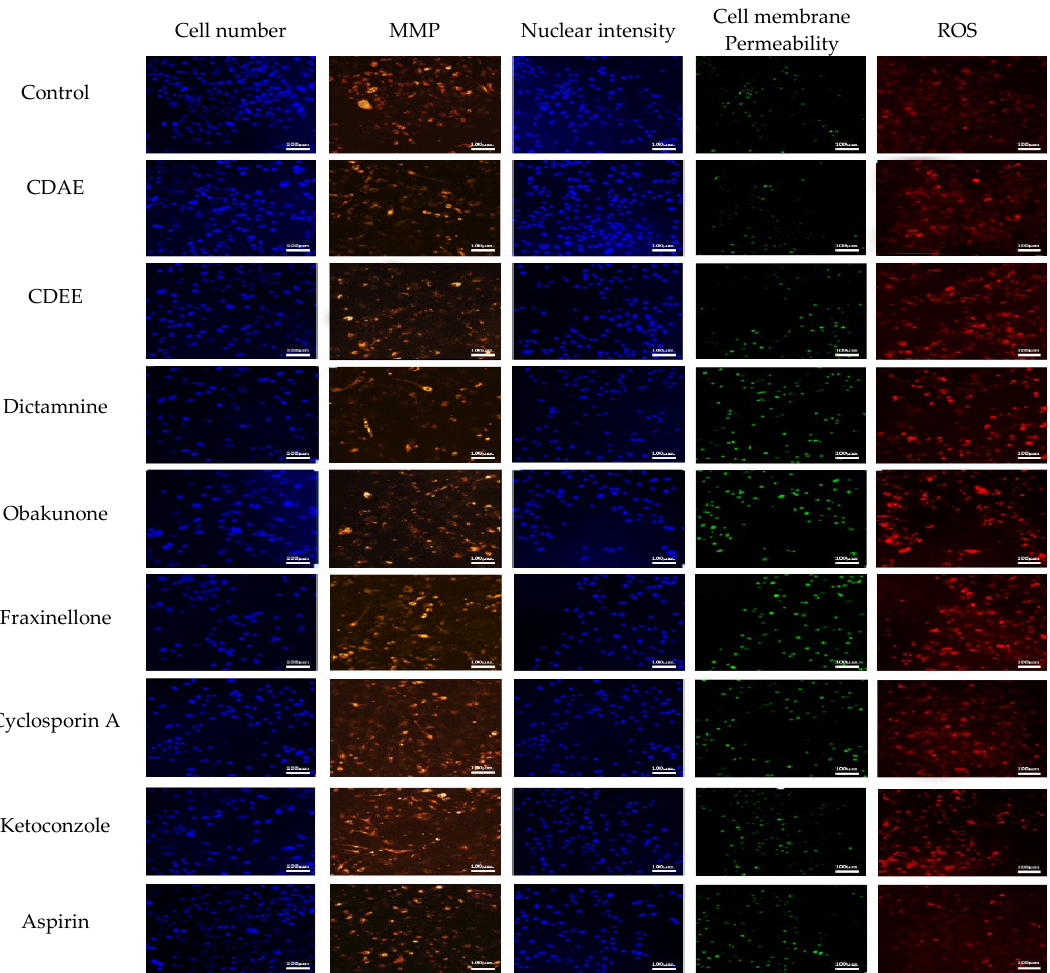
Figure 5. Representative images of HepG2 cells incubated with CDAE and CDEE using a high content imaging assay. The scale bar corresponds to 100 µm.